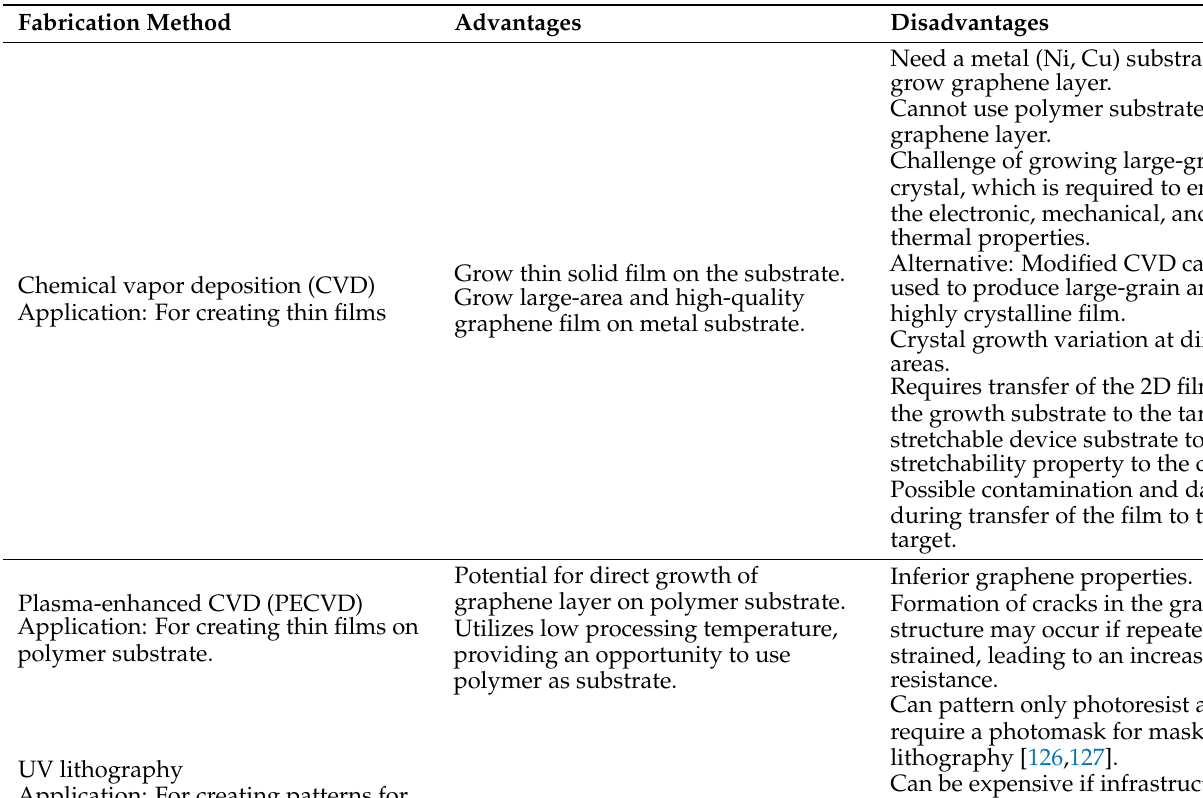
Table 3. Summary of fabrication methods with their advantages and